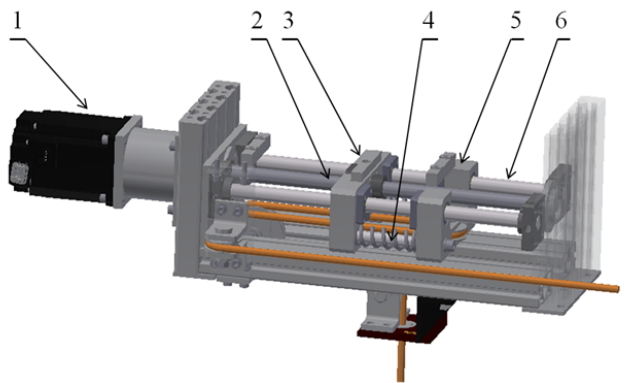
Figure 3. Visualization of the dynamic patient weight compensation system.